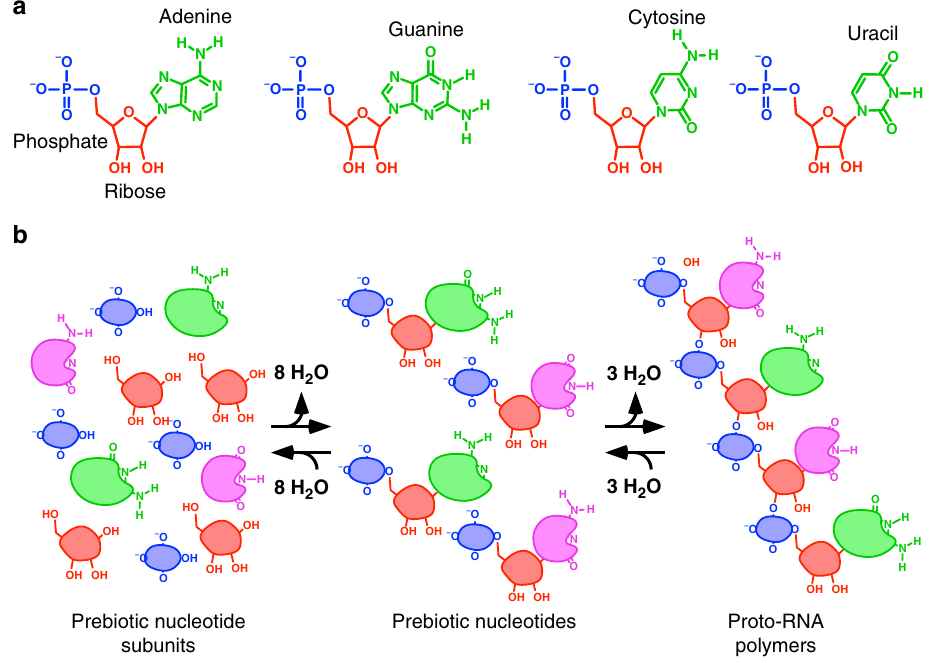
Fig. 1 The RNA nucleotides and a hypothetical process for prebiotic nucleotide and proto-RNA formation. a The extant RNA nucleotides. The name of each nucleobase is given above its respective nucleotide. The phosphate and ribose subunits of the adenine nucleotide are labeled to emphasize the modular molecular structure of nucleotides. b Schematic representation of prebiotic nucleotide synthesis and polymerization. The subunits of the prebiotic nucleotides are shown as nondescript molecular entities because their identities are unknown. Some functional groups of the extant nucleotides are shown on the prebiotic nucleotide subunits to emphasize that some chemical and structural features of the earliest nucleotides may have been retained over the course of evolution due to the constraints imposed by a requirement for forward compatibility, such as the ability to form Watson-Crick, or similar, base pairs. The reversibility of nucleotide formation and polymerization, indicated by reverse arrows, emphasizes our hypothesis that early nucleotides and proto-RNA polymers would have had linkages that were more thermodynamically favored and less kinetically trapped compared to the extant nucleotides and nucleic acids